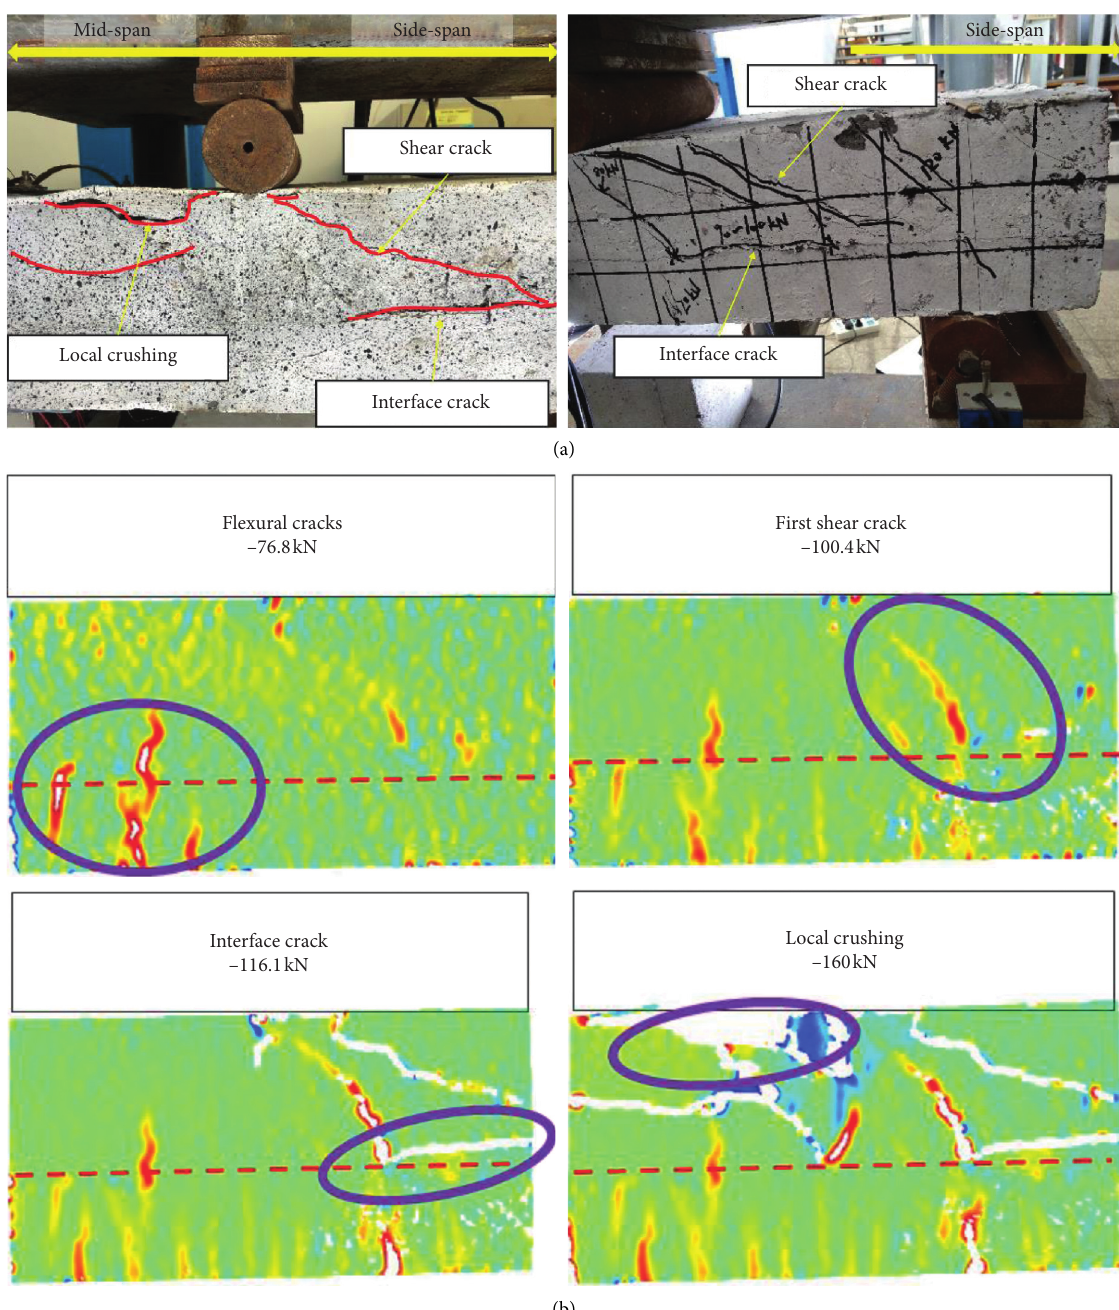
Figure 9: Failure patterns and damage evolutions of specimen U60-LS. (a) Photos for failure pattern. (b) Damage tracking with DIC